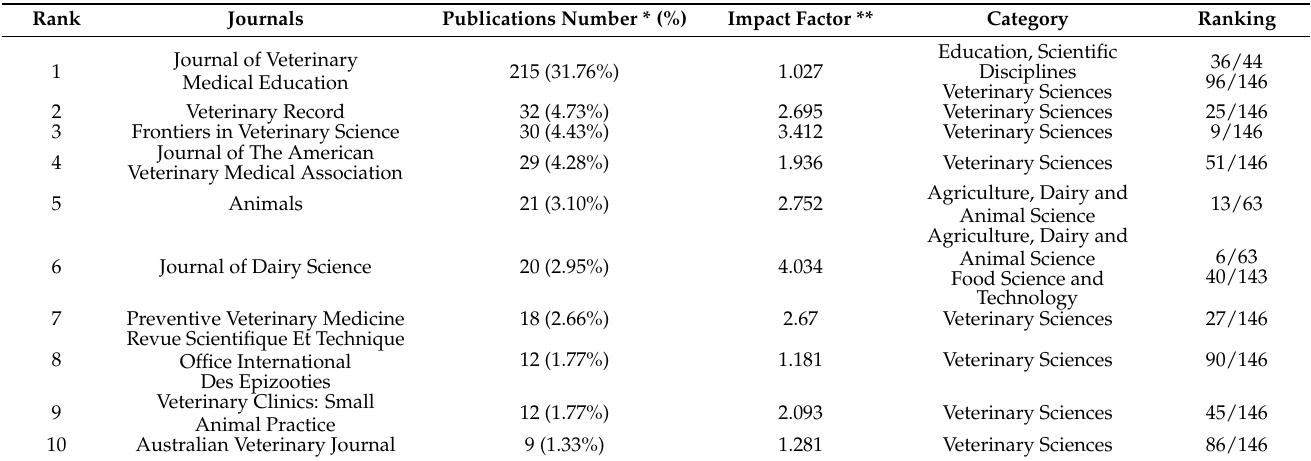
Table 4. The top 10 productive journals for veterinary communication education publications (VCEPs) from 2000 to